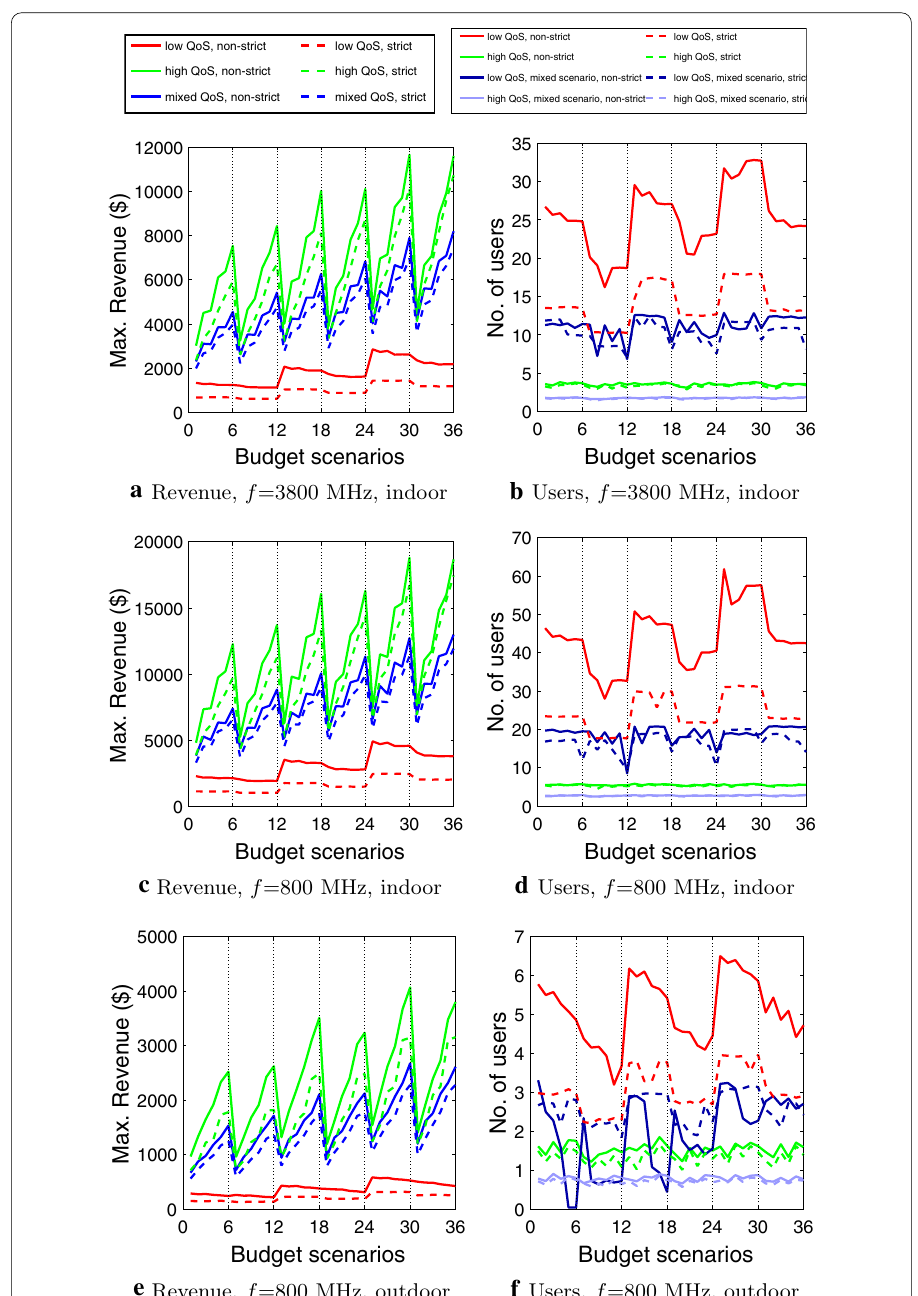
Fig. 7 Comparison of the max. revenue and the corresponding number of users for the non-strict and the strict choice of the QoS